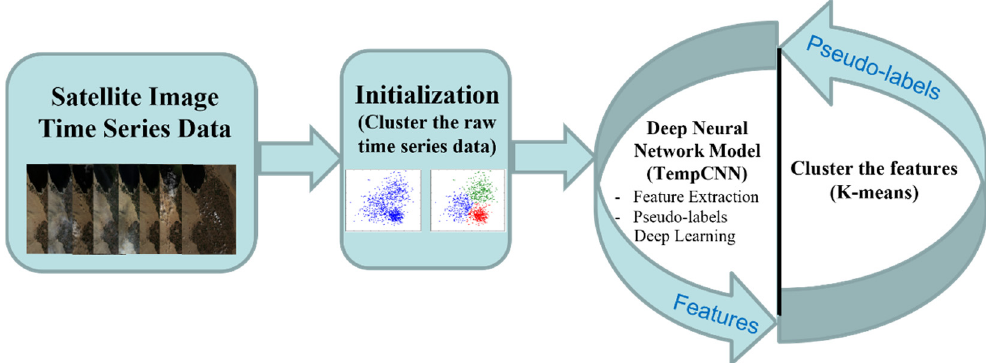
Figure 1. Overall flow for the proposed method, including the deep neural network model and clustering model.